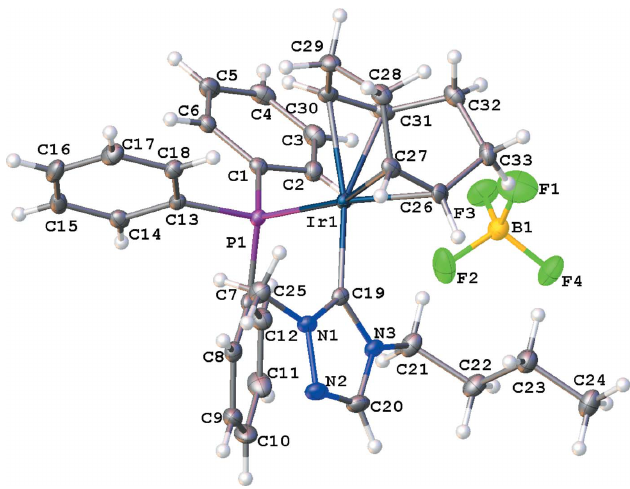
Figure 1 The molecular entities in the crystal structure of the title compound ( 4 ). Displacement ellipsoids are drawn at the 50% probability